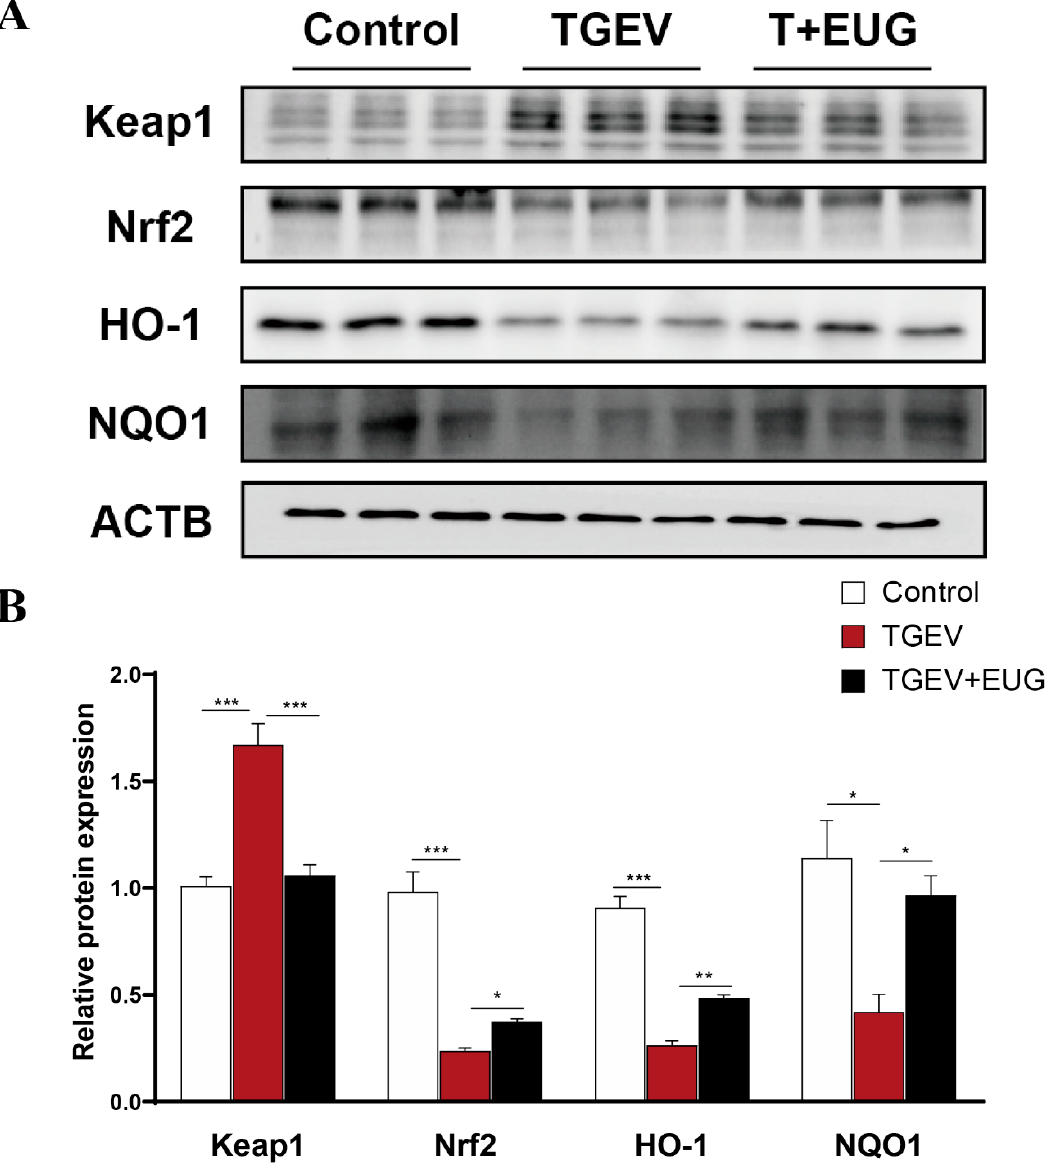
Figure 8. Eugenol ameliorates TGEV-induced oxidative stress in IPEC-J2 cells. ( A , B ) Protein abun- dance of Keap1, Nrf2, HO-1 and NQO1 in IPEC-J2 cells ( n = 3). Data are expressed as the mean ± SEM. * p < 0.05, ** p < 0.01, *** p < 0.001.